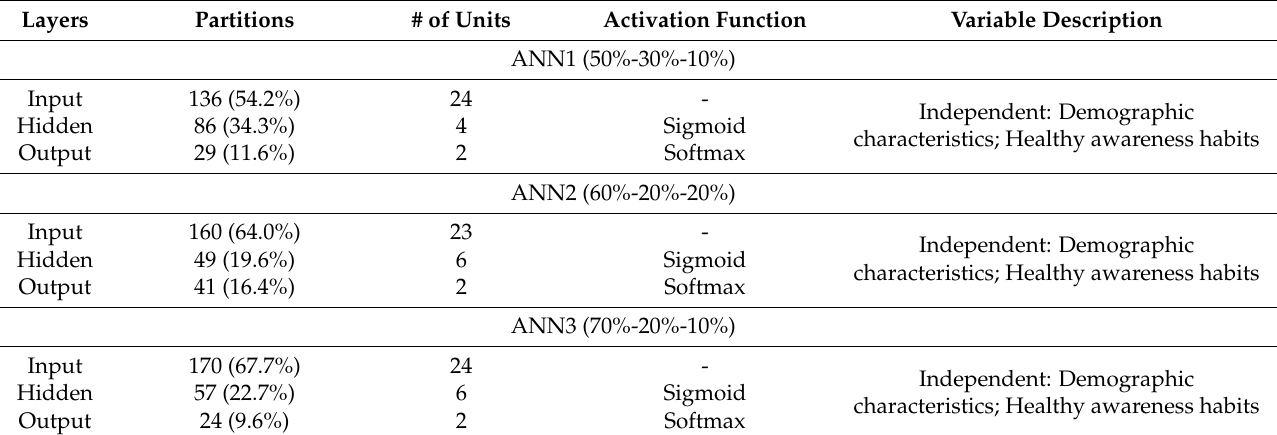
Table 3. Network information for three ANNs.